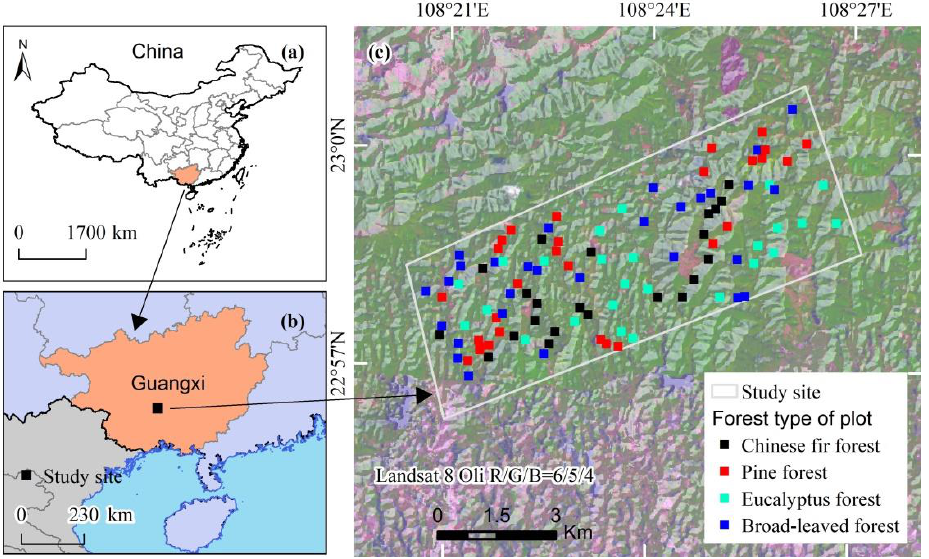
Figure 1. (a) Location of the Guangxi Zhuang Autonomous Region in China; (b) Location of the Figure 1. ( a ) Location of the Guangxi Zhuang Autonomous Region in China; ( b ) Location of the study site in Guangxi; (c) Distribution of the field plots. study site in Guangxi; ( c ) Distribution of the field